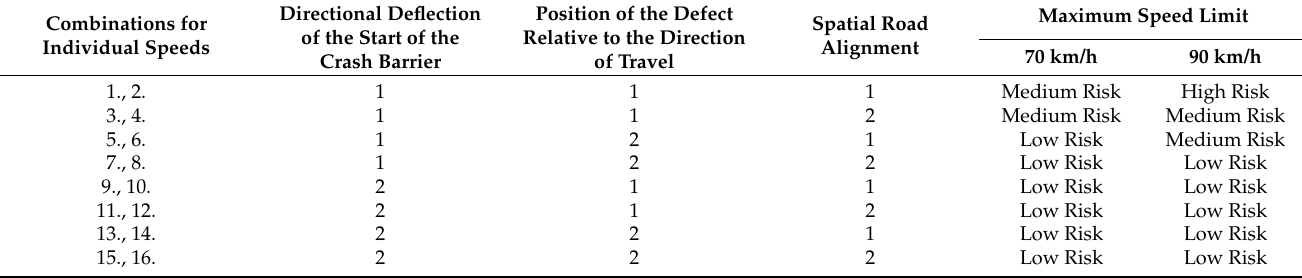
Table 4. Predicted risk level of individual exposures for defect—Short turned down end of the crash barrier.